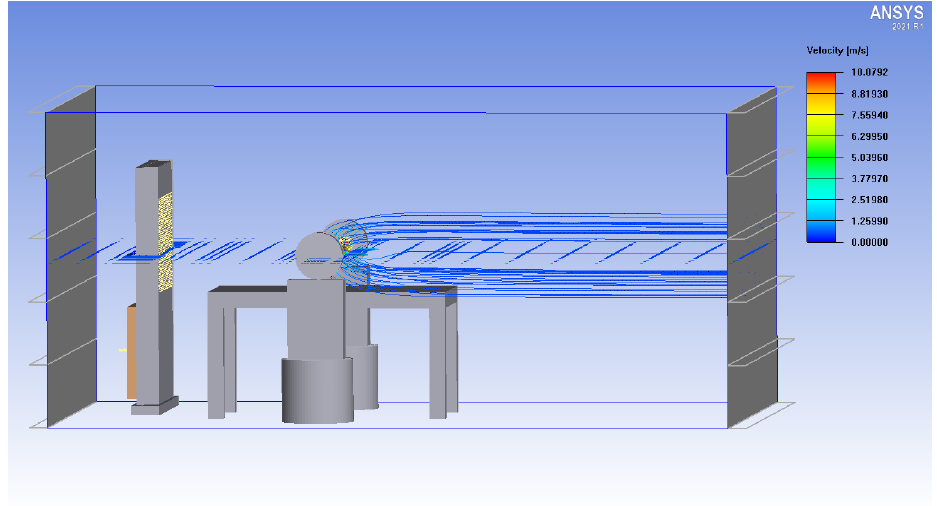
Figure 25. Air purifier simulation in the quarantine station at a low rotation speed.